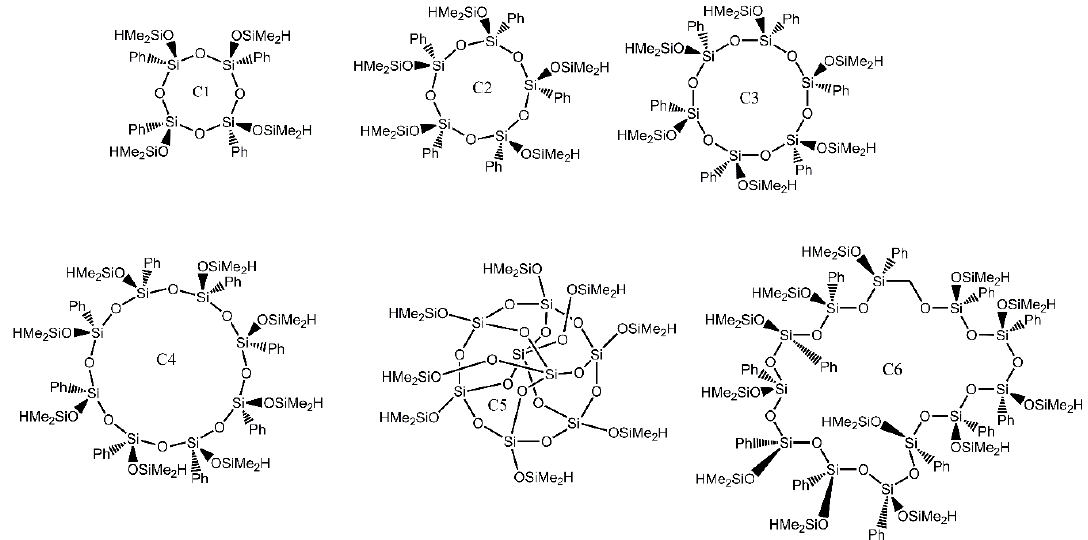
Figure 15. Synthesis of functional cores for further synthesis of star shaped PDMS. Based on Ref. [36].